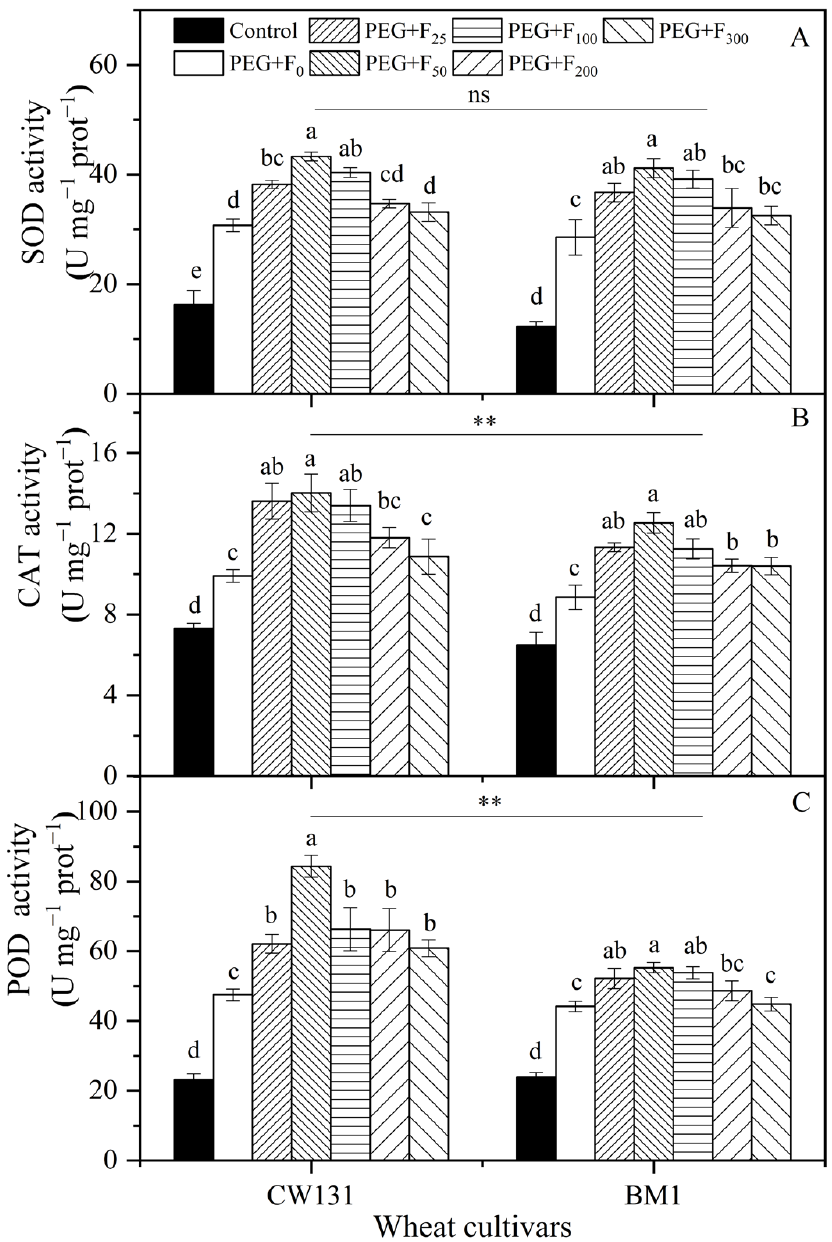
Figure 4. Activities of antioxidant enzymes: superoxide dismutase (SOD) ( A ), catalase (CAT) ( B ), and peroxidase (POD) ( C ) of two winter cultivars (CW131 and BM1) under different fullerol additions (concentrations range from 0 to 300 mg L − 1 ) and PEG (20% polyethylene glycol) treatment. Mean values ± SE are shown ( n = 3). Bars with different letters for the same cultivar imply a significantly difference at p < 0.05. For ANOVA results, **, p < 0.01; ns, not significant.